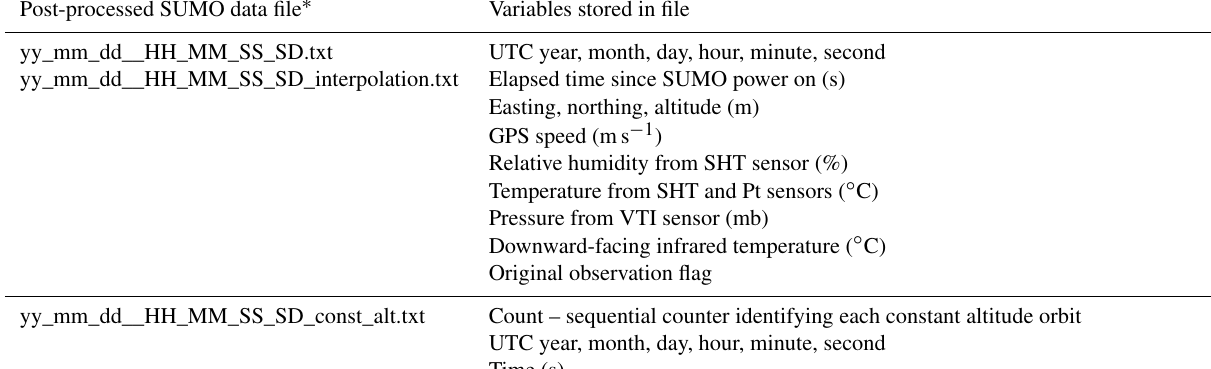
Table A2. Post-processed SUMO data files and data archived in each type of post-processed file. Post-processed SUMO data file